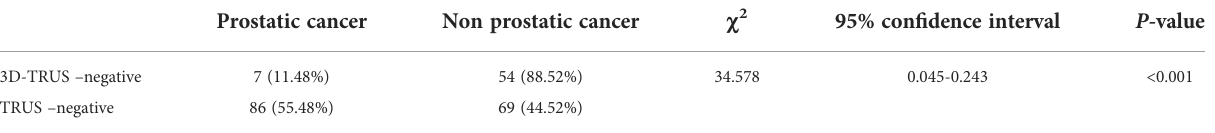
TABLE 7 Comparison of negative rate of biopsy session between 3D-TRUS and TRUS.